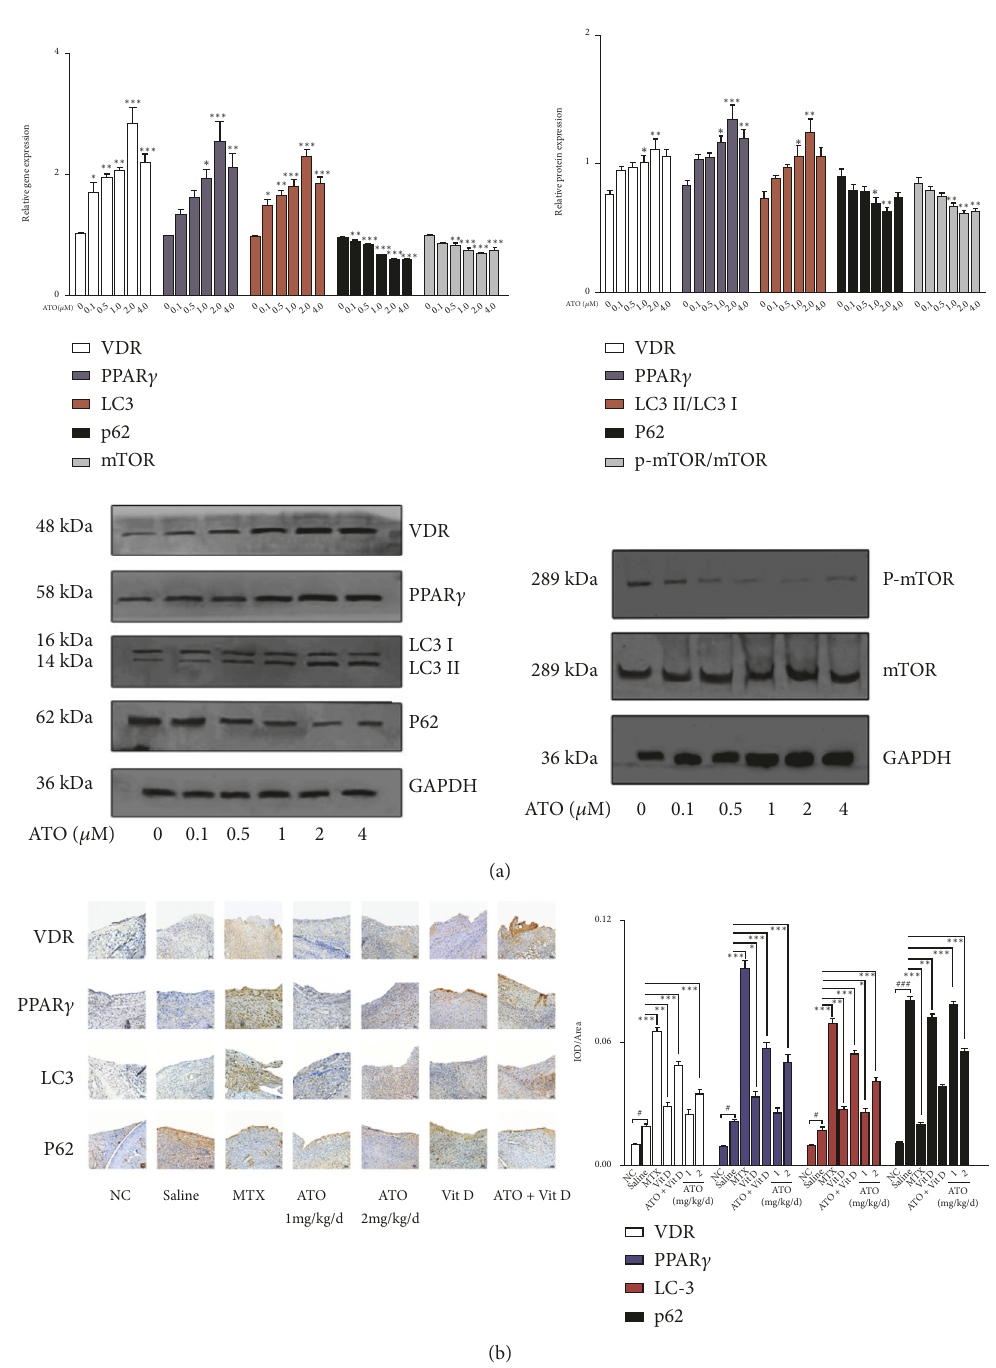
Figure 2: Arsenic trioxide (ATO) and Vitamin D rescue the defective Vitamin D receptor (VDR)-PPAR- 𝛾 autophagy functional module in rheumatoid arthritis (RA) . (a) Increased expression levels of PPAR- 𝛾 , VDR, and LC-3 and decreased expression levels of p62 after ATO administration in RA fibroblast-like synoviocytes (FLS) ( n =3; ∗ p < 0.05; ∗∗ p < 0.01). Data are expressed as means ± standard error of the mean (SEM). (b) Increased average integrated optical density (IOD) values for VDR, PPAR- 𝛾 , LC-3, and p62 in synovial tissue in collagen-induced arthritis-(CIA-)salinemice(saline)comparedwithnormalcontrols(NC).CIAmiceunderATOandmethotrexate(MTX)treatmentsshowed additional increased average IOD values for VDR, PPAR- 𝛾 , and LC-3 but decreased p62 in synovial tissue compared with the saline group ( n =6; ∗ p < 0.05; ∗∗ p < 0.01; ∗ ∗ ∗ p < 0.001, experiment versus saline). Magnification = 20 × . Bars = 50 𝜇 m. Data are expressed as means ±